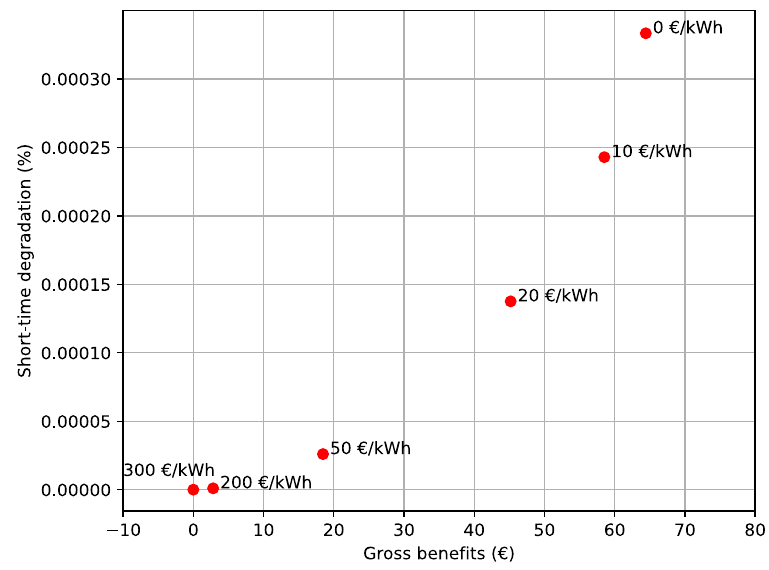
Figure 4. Degradation vs. gross